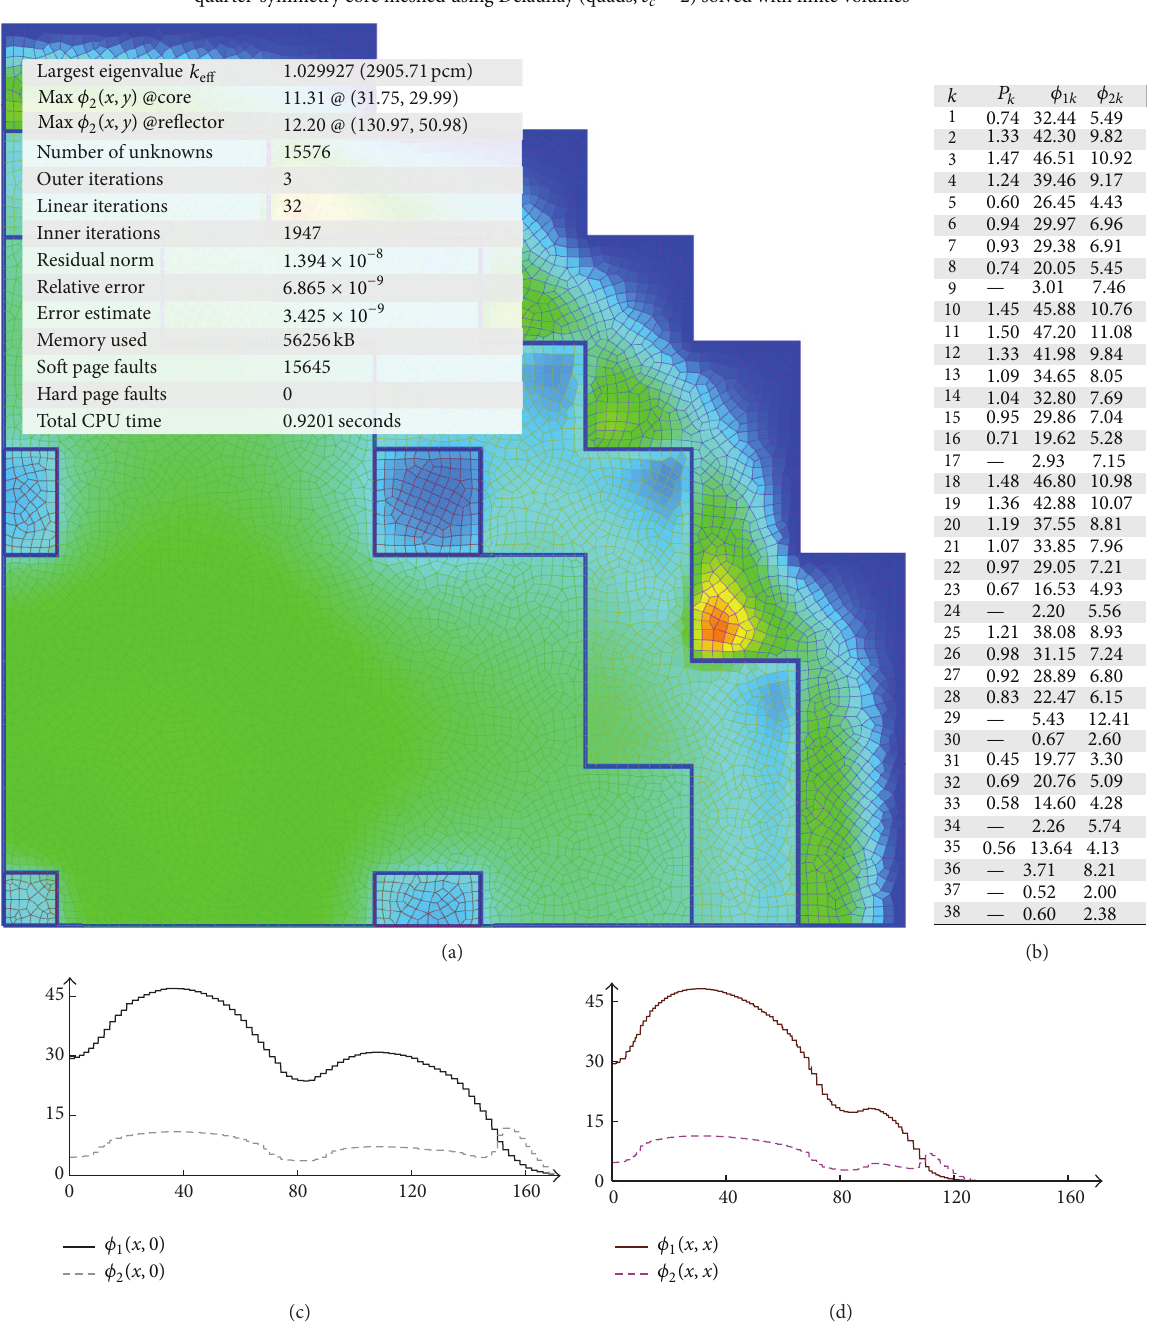
Figure 11: (a) Mesh and thermal flux distribution. (b) Power and fluxes. (c) Flux distribution 𝜙 𝑔 (𝑥,0) along the 𝑥 -axis. (d) Flux distribution (𝑥,𝑥) along the 𝜙 𝑔